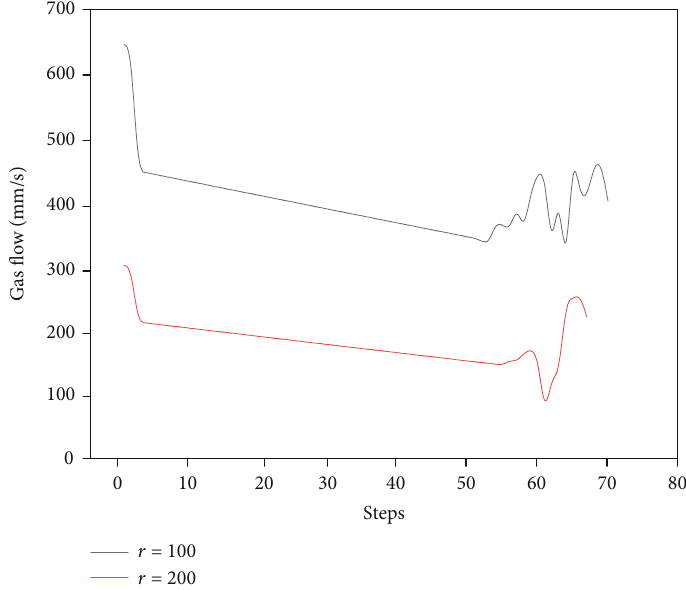
Figure 8: 100mm and 200 mm variation of gas fl ow in borehole.